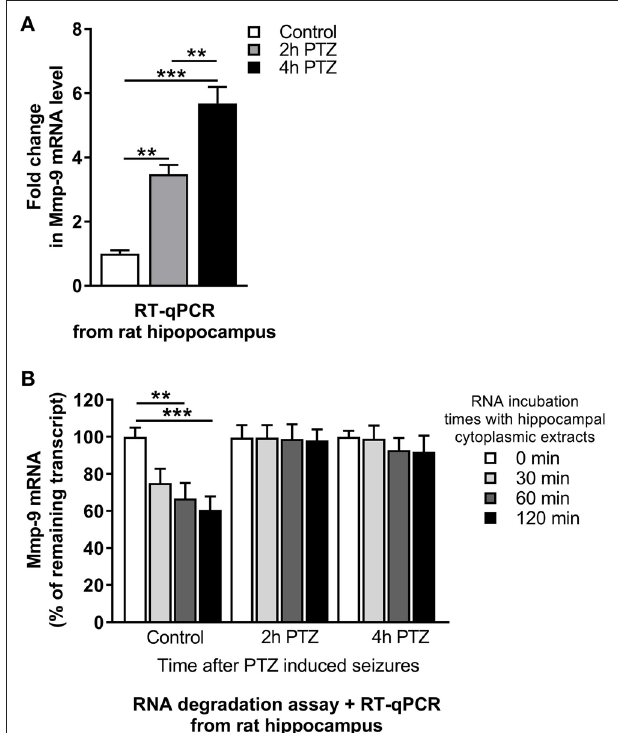
FIGURE 1 | mRNA stabilization is involved in Mmp-9 mRNA upregulation after seizure-induced neuronal activation. (A) Mmp-9 mRNA accumulates after PTZ-induced seizures in the rat hippocampus. Mmp-9 mRNA increased progressively after PTZ-evoked neuronal activation in the rat hippocampus in vivo . For each analysis, equal amounts of RNA samples isolated from unstimulated (control) and PTZ-treated (2 and 4h after the onset of seizures) rat hippocampi were used. Mmp-9 expression was normalized against 18S rRNA expression. Data are presented as fold change in mRNA expression. One-way ANOVA was applied followed by Tukey’s multiple comparisons test. Values are mean ± SEM (** p < 0.01; *** p < 0.001; n = 4). (B) Mmp-9 mRNA is significantly stabilized in response to PTZ-induced seizures in the rat hippocampus. A degradation assay of Mmp-9 mRNA was conducted using equal amounts of RNA isolated from the rat hippocampus and incubated with cytoplasmic protein lysates obtained from unstimulated (control) and PTZ-treated (2 and 4h after the onset of seizures) rat hippocampi. The results are presented as a percentage of time zero. Mmp-9 expression was normalized against 18S rRNA expression. Two-way ANOVA followed by Tukey’s multiple comparisons test. Values are mean ± SEM (** p < 0.01; *** p < 0.001; n =